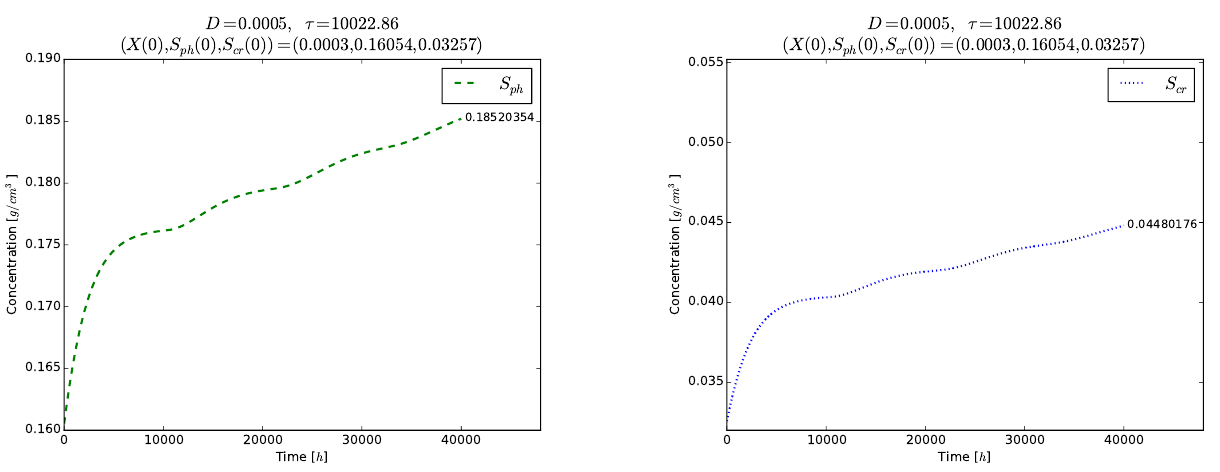
Figure 4. Example 1. Left plot: solutions ( X ( t ) , S ph ( t ) , S cr ( t )) of (3)–(5). Right plot: transient oscillations of the phase variable X ( t ) .